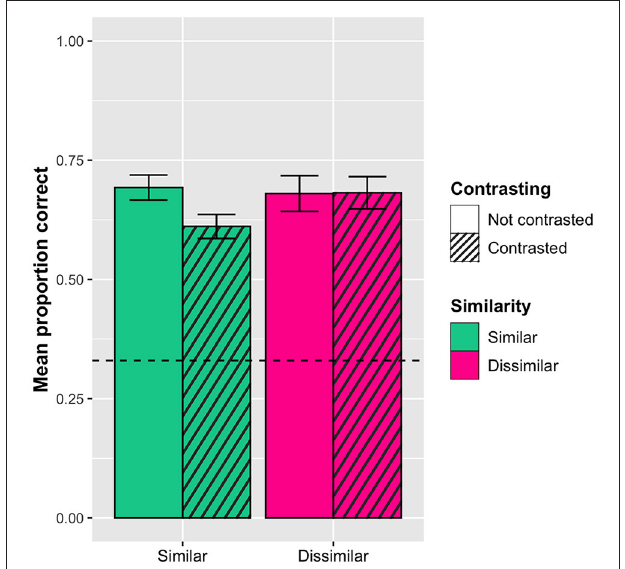
FIGURE 4 | Interaction effect between sorting and similarity (orthographic and semantic similarity collapsed) with 95% confidence interval bars. Dashed line represents chance level (0.33). The similar words are significantly less accurate in the contrasted condition compared to the no contrasting